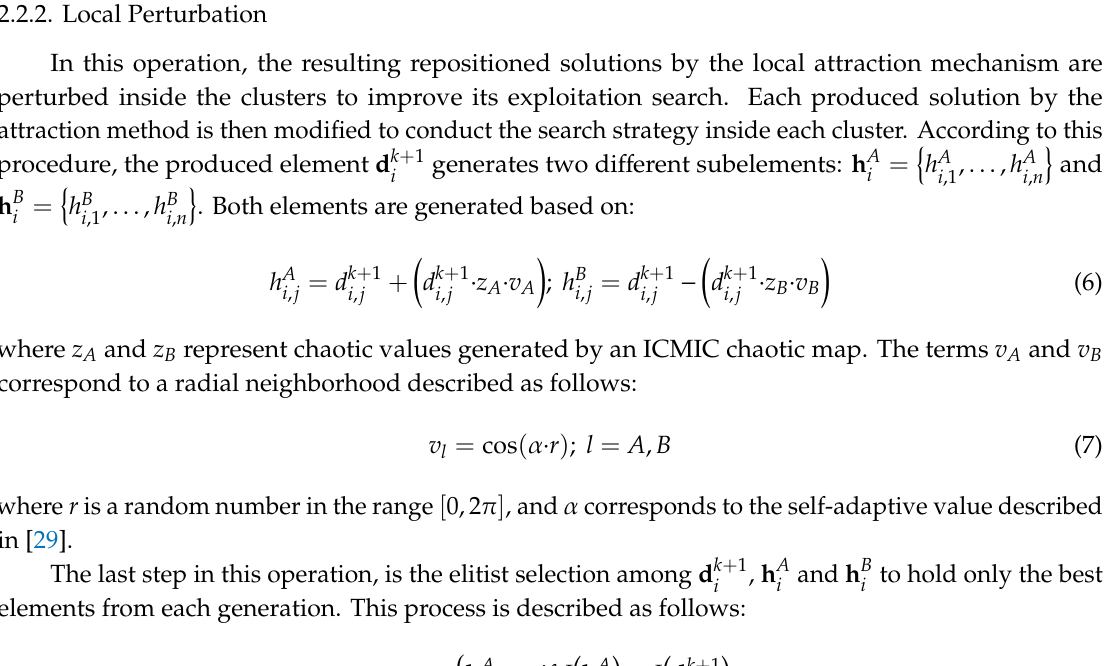
Figure 1. Local attraction operation in two scenarios: ( a ) cluster containing several elements ( b ) cluster containing few elements. The arrows represent ( a ) small search capabilities (low exploitation, high exploration) inside the cluster and ( b ) large search capabilities (high exploitation, low exploration) inside the cluster.